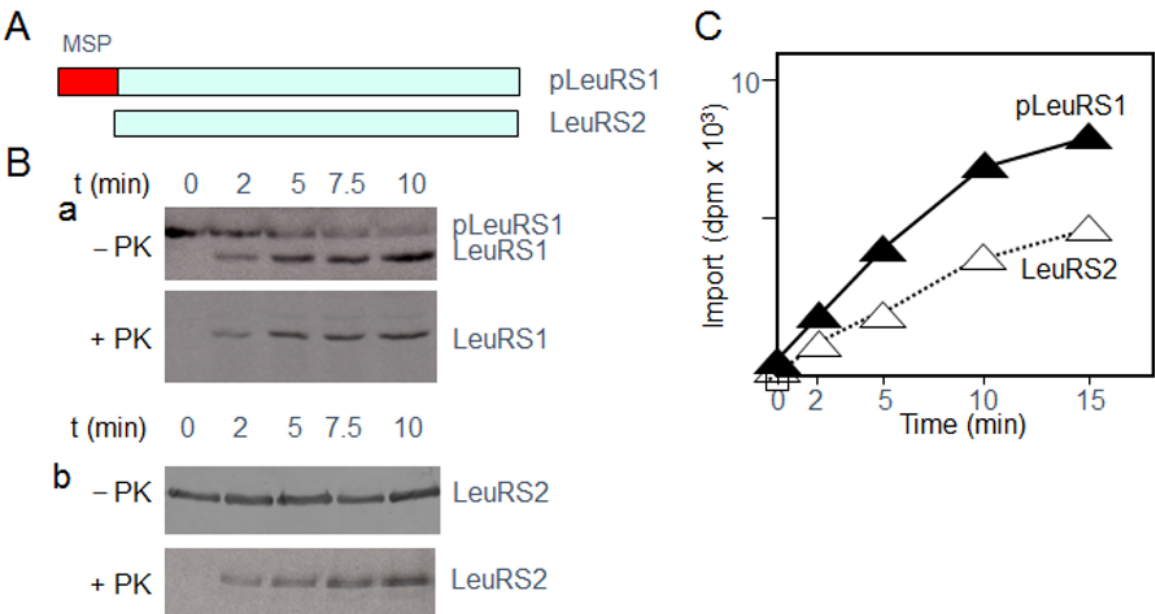
Figure 1. In vitro-uptake of pLeuRS1 and LeuRS2 into isolated Arabidopsis mitochondria. ( A ) Schematic representation of pLeuRS1 and LeuRS2, differing by the presence of a mitochondrial signal peptide (MSP). ( B ) In vitro-import of 35 S-labeled pLeuRS1 (Panel a) and 35 S-labeled LeuRS2 (Panel b) into isolated mitochondria. The autoradiogram shows 35 S-pLeuRS1 and 35 S-LeuRS2 in re-isolated mitochondria before ( − ) and after (+) proteinase K (PK) treatment. Note the processing of pLeuRS1 into the mature form lacking the mitochondrial signal peptide (MSP), whereas LeuRS2 does not undergo a processing step during import. ( C ) Time course of appearance of mature-sized LeuRS1 (black triangles) and LeuRS2 (white triangles) in proteinase K-treated